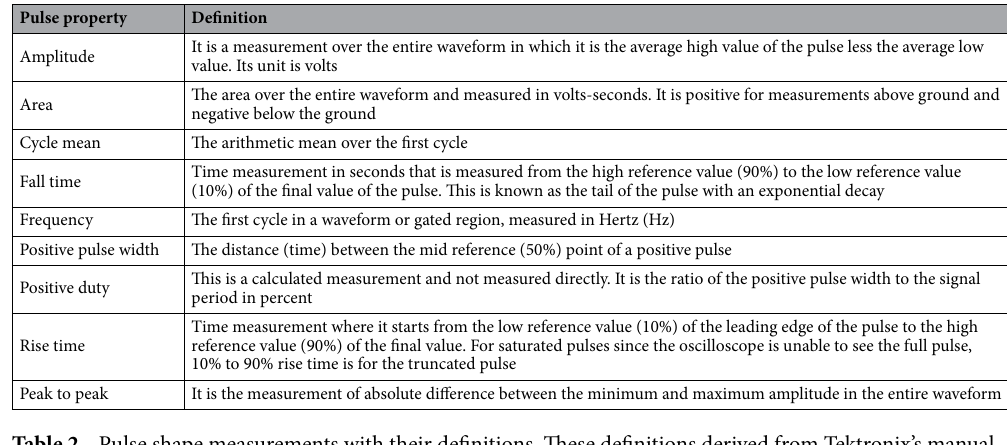
Table 2. Pulse shape measurements with their definitions. These definitions derived from Tektronix’s manual for the TBS2000